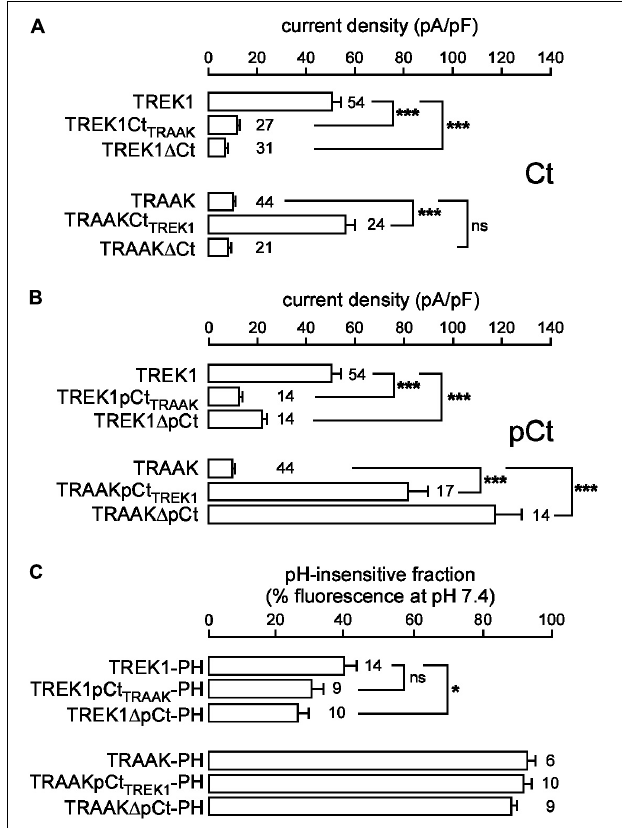
FIGURE 2 | Proximal C-ter domain (pCt) modulates TREK1 and TRAAK current amplitudes but not their cellular distribution. (A,B) Current densities at 0 mV of HEK cells expressing wild type or mutated channels. Ct, full cytoplasmic C-ter (A) . pCt, proximal cytoplasmic C-ter (B) . (C) % of the fluorescence sensitive to an extracellular acidification (pH 6) of live HEK cells expressing pHluorin-tagged channels. This % corresponds to the fraction of channels expressed at the plasma membrane. (A–C) Data are presented as mean ± SEM. ∗ p < 0.05, ∗∗∗ p < 0.001, and ns, not significant. The number of cells is indicated (one-way Anova with Tukey’s